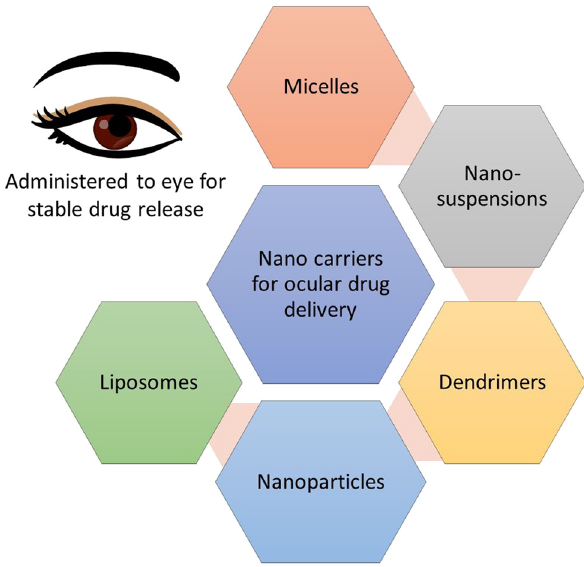
Figure 12: Smart nano - carriers for ocular drug